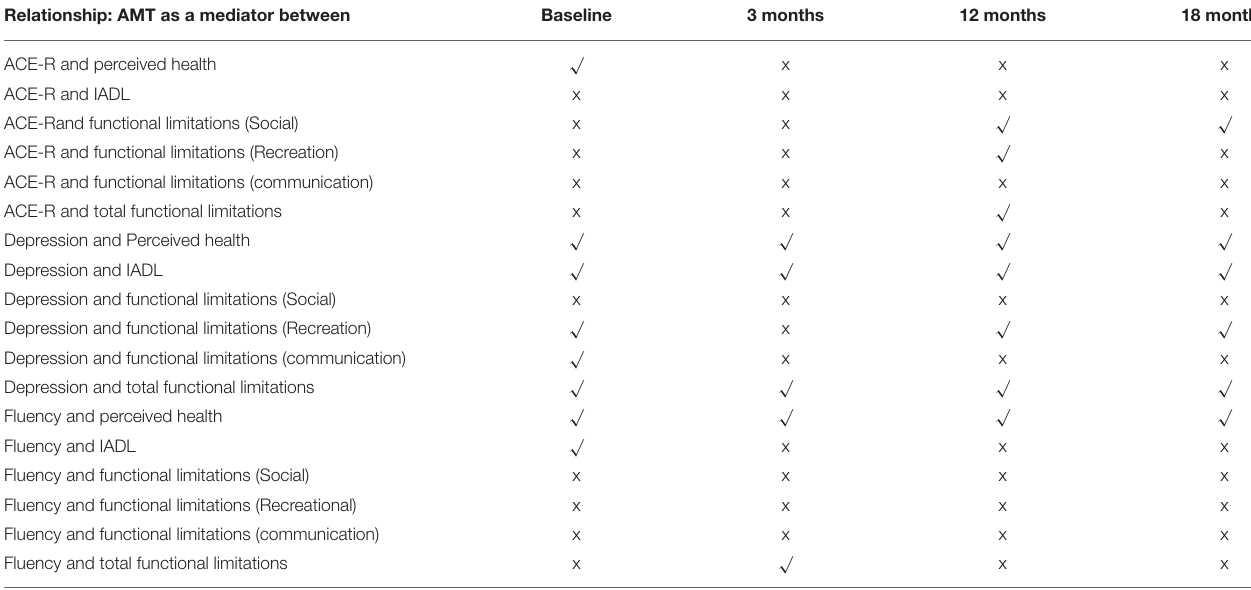
Relationship: AMT as a mediator between Baseline 3 months 12 months 18